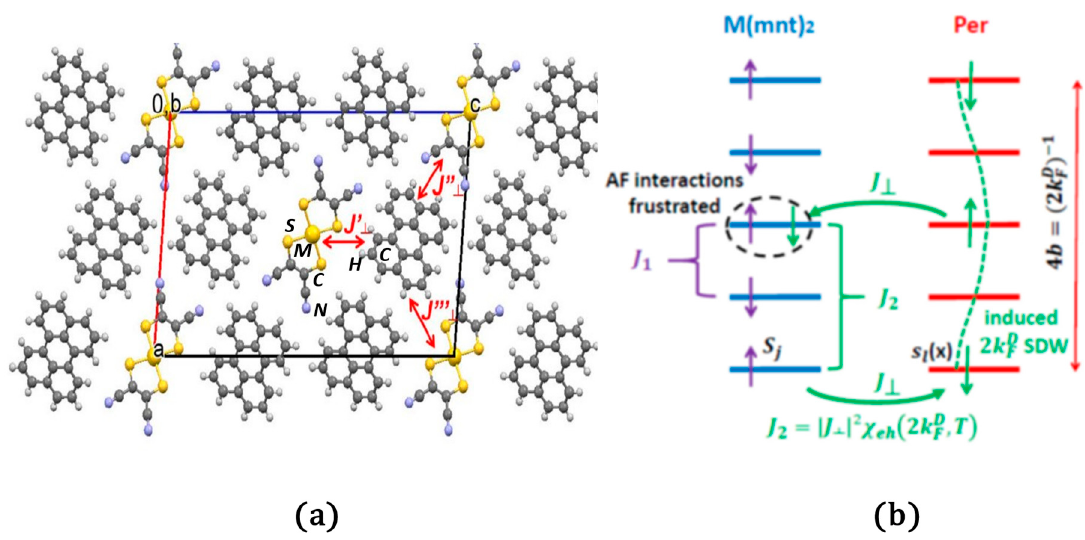
Figure 6. ( a ) Crystal structure of α -Per 2 -M(mnt) 2 projected along the stack direction b, which reveals the presence of segregated Per and dithiolate stacks. The atoms are labelled. First, neighbor inter- stack [M(mnt) 2 ]—Per AF exchange coupling J ⊥ are schematically indicated (note that there are three different types of interactions per Per). ( b ) Schematic representation of competing S = 1/2 AF ex- change couplings in α -Per 2 -M(mnt) 2 derivatives for M = Ni, Pd and Pt. J 1 is the first neighbor direct AF exchange interaction on dithiolate stack. J 2 is the second neighbor indirect RKKY exchange in- teraction mediated by the induced 2𝑘 (cid:3007)(cid:3005) SDW on the Per stack.